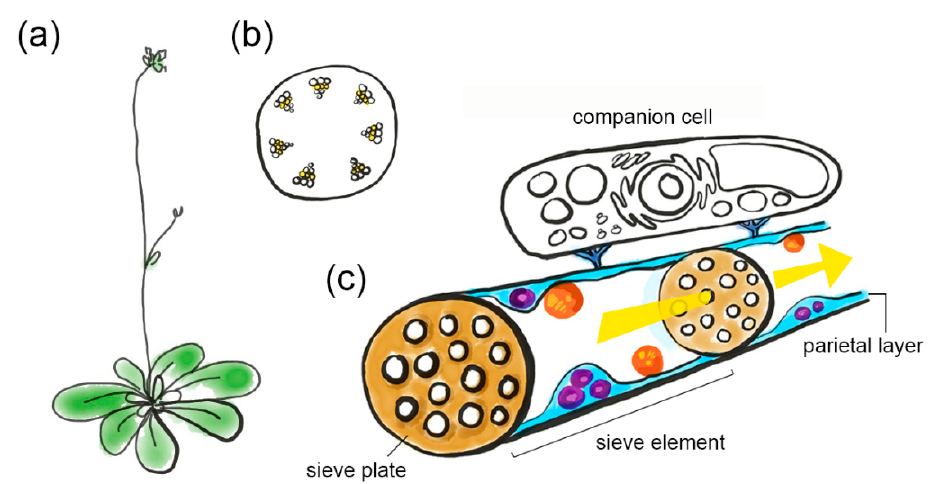
Figure 1. An impression of phloem architecture. ( a ) Arabidopsis plant. ( b ) Transverse section through the inflorescence stem, showing vascular bundles (yellow is sieve tube region). ( c ) Sieve tube with phloem sap allocation (yellow arrow) through sieve elements, separated by sieve plates. Sieve elements contain a parietal layer with phloem plastids (orange) and mitochondria (purple) that are embedded in the sieve element reticulum (light blue). Sieve element plasma membrane and cytoplasm are not depicted separately. Sieve elements are connected to a companion cell (colorless) via plasmodesmata pore units (dark blue).